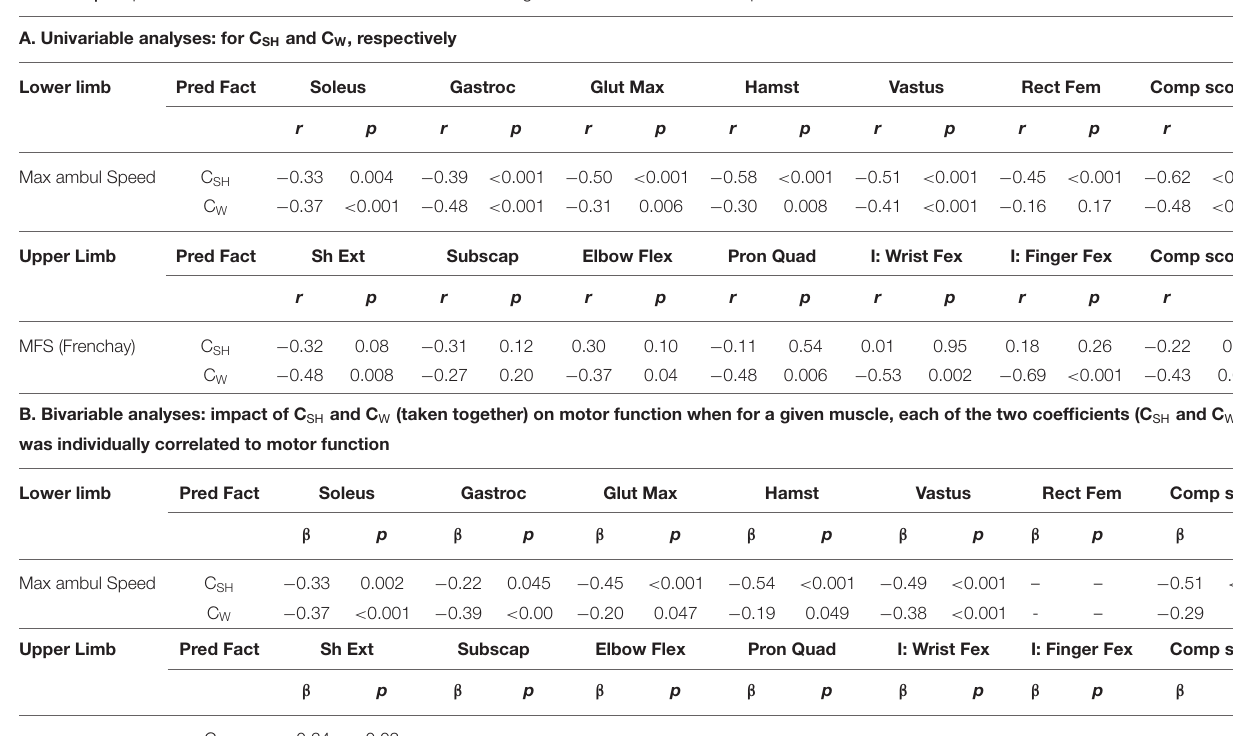
TABLE 2 | Respective contribution of the muscular and the neurological disorders to functional